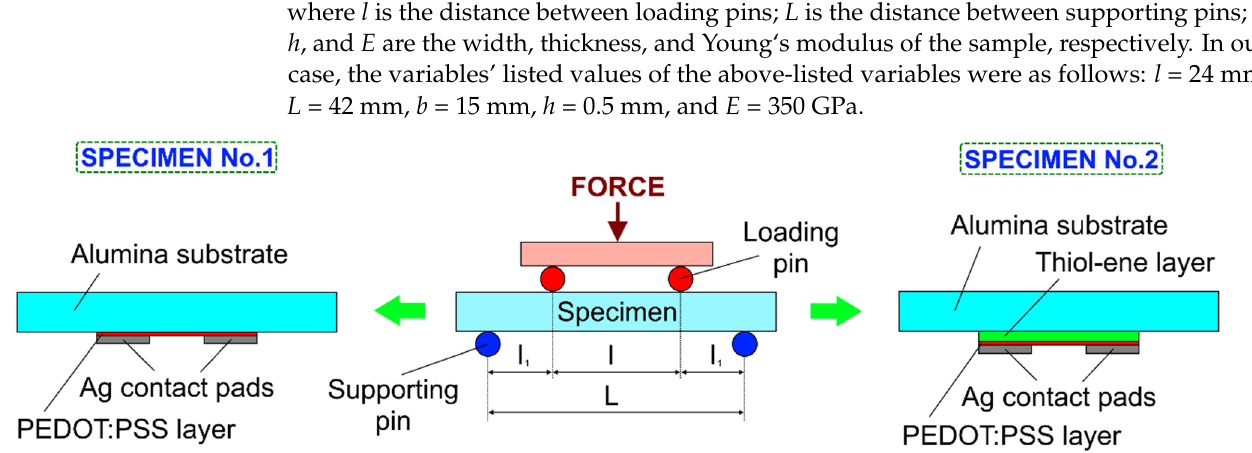
Figure 2. Four-point bending test setup.